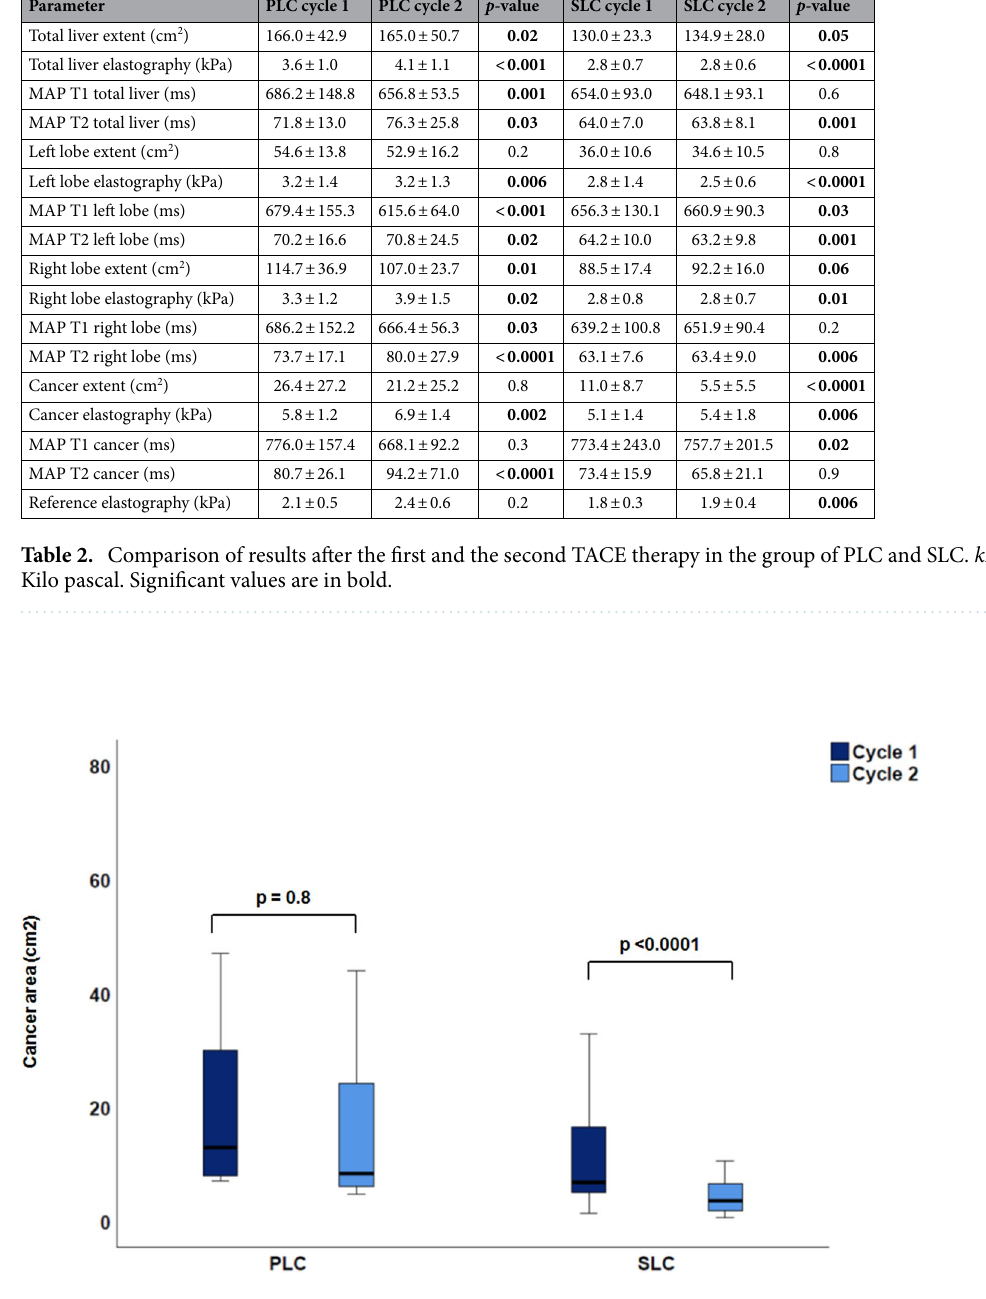
Figure 3. Cancer area in PCL vs. SLC after the first and second cycle of TACE. A decrease of area was shown from the first to the second TACE cycle in each